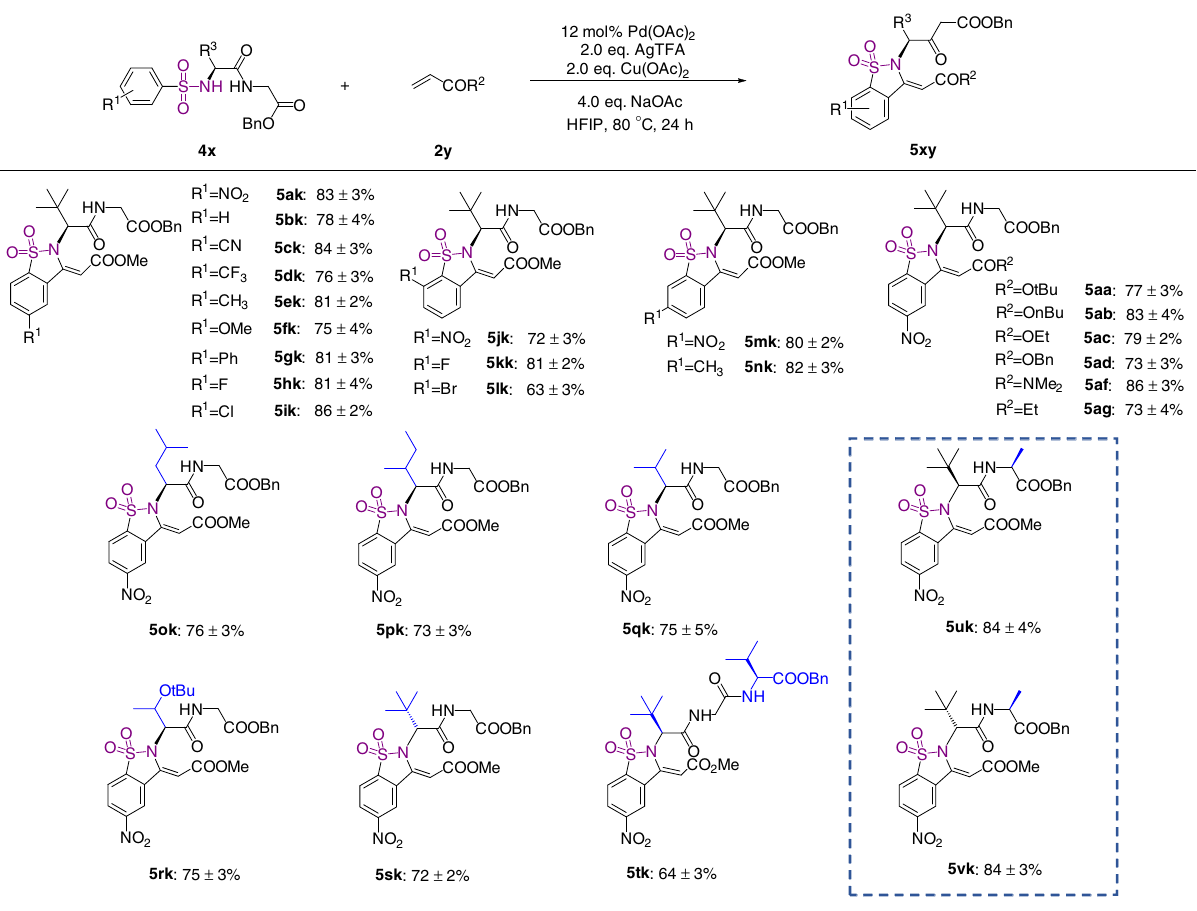
Fig. 3 Scope of the cyclization reaction of benzosulfonamide peptide conjugates. The isolate yields were determined by three repeats of